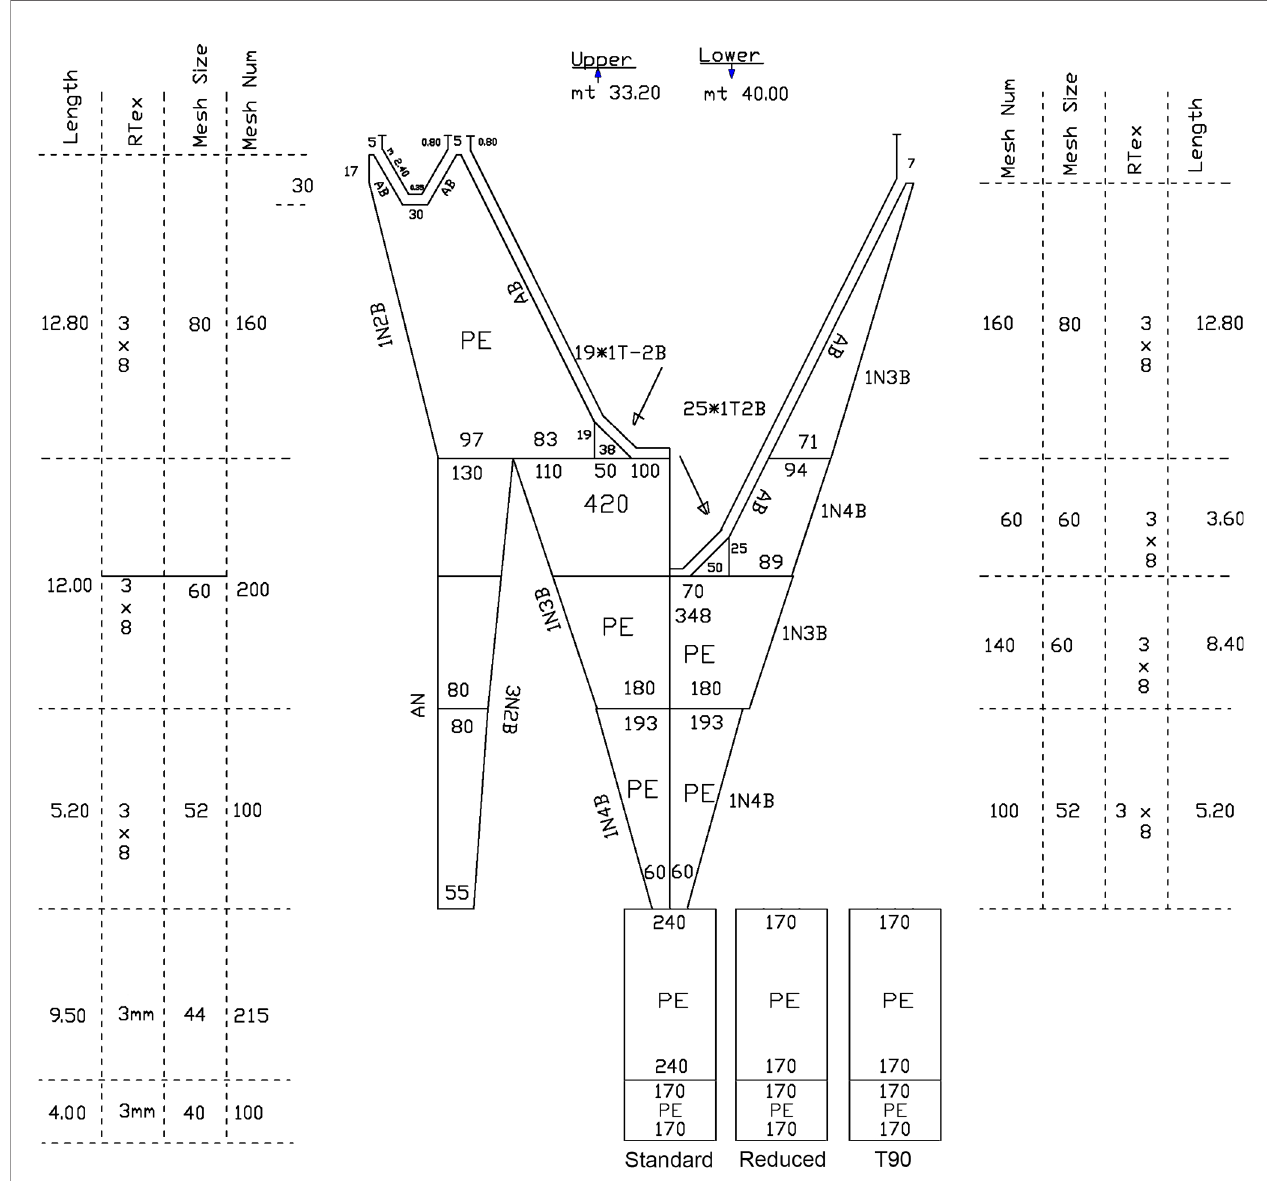
FIGURE 1 | Scheme of the trawl net used in the survey, with details of the extension piece plus codend of the three net con fi gurations tested in the survey (Standard, Reduced,